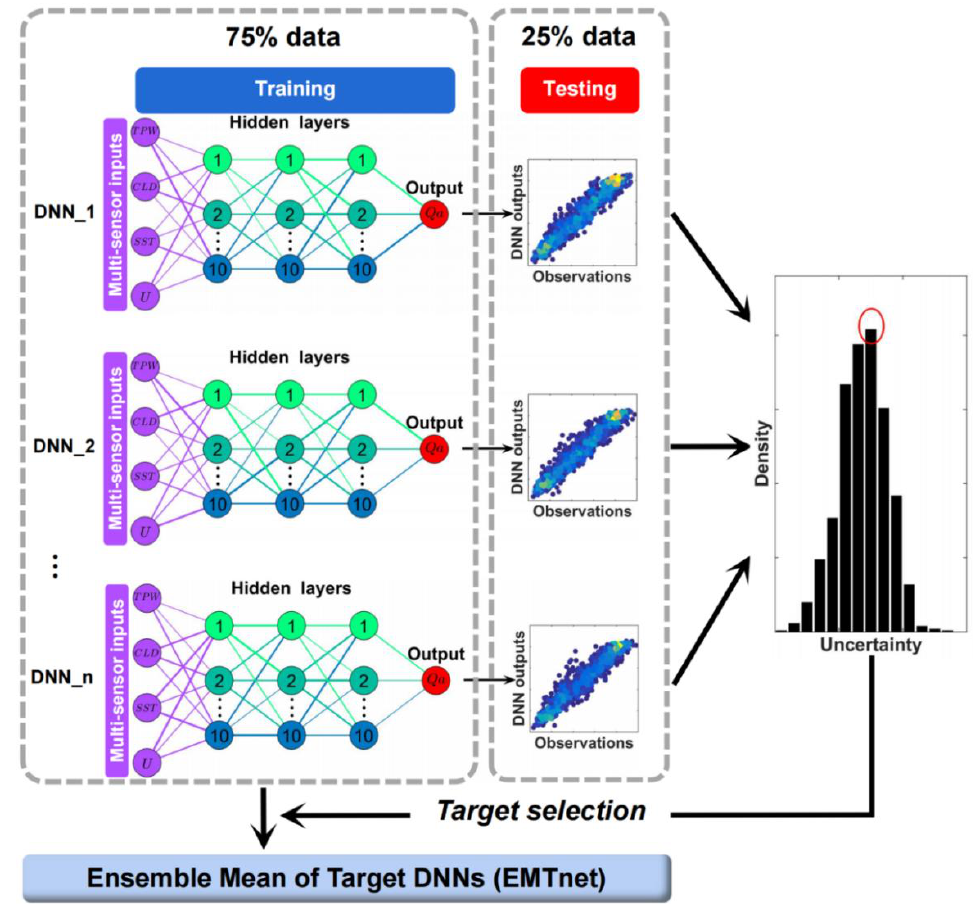
Figure 3. Architecture of the EMTnet. Each DNN_ n ( n = 1, 2, 3, … ) uses 75% randomly sampled data from all in situ observations as training data, while the remaining 25% are used as testing data.